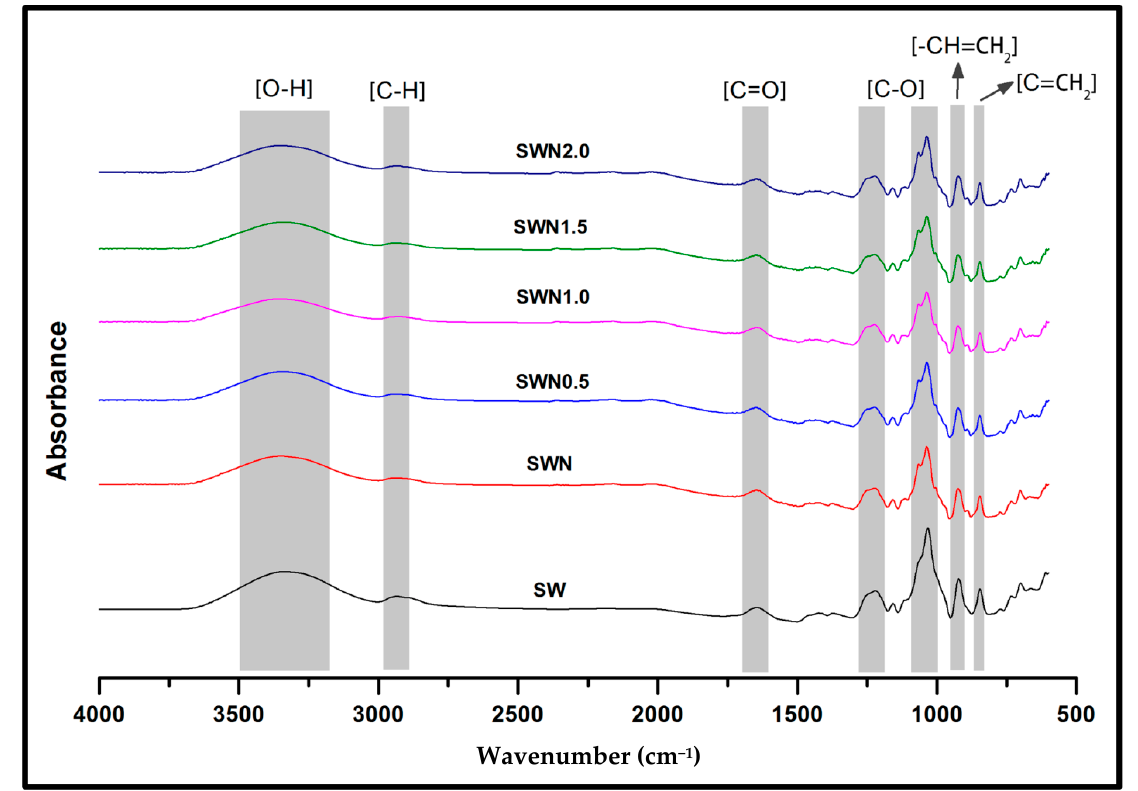
Figure 2. FT-IR spectra of seaweed, seaweed-neem, seaweed-neem, and gamma irradiated films.